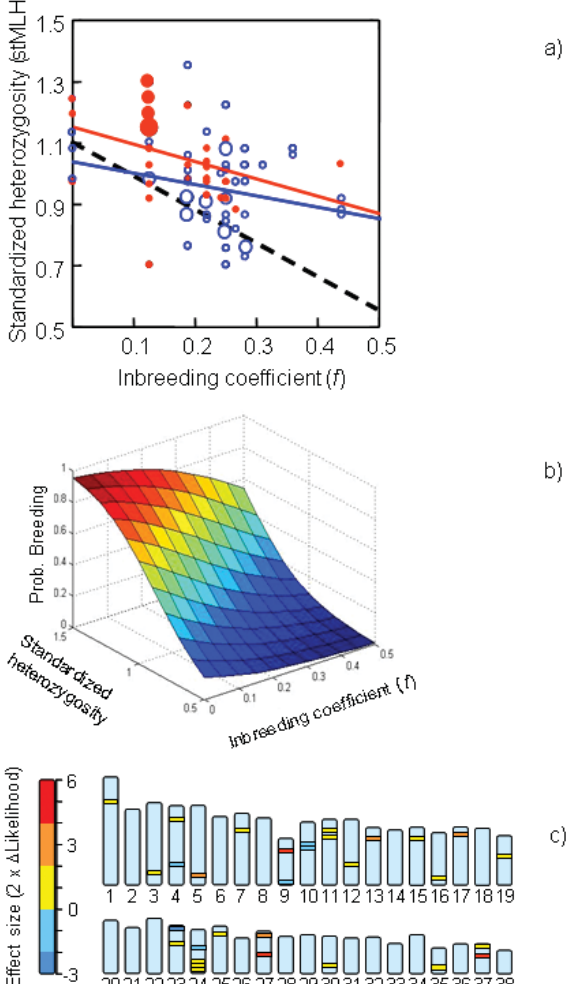
Figure 2. Reproductive status and inbreeding coefficients of Scandinavian wolves in relation to heterozygosity and chromosomal location of 31 microsatellite loci. a) The relationship between inbreeding coefficient ( f ) and standardized heterozygosity (stMLH). Individuals that recruited to the breeding population (filled red circles, solid red regression line) exhibited higher stMLH than those that did not enter the breeding population (open blue circles, solid blue regression line) (ANCOVA: inbreeding coefficient, F 1,82 =7.96, P =0.006; breeding recruitment success , F 1,82 =7.43, p =0.008). The stippled black line shows the expected relationship between f and stMLH. b) Breeding probability against inbreeding coefficient ( f ) and stMLH based on model estimates from a logistic regression analysis ( f , b = 2 5.84, p =0.06; stMLH, b =4.87, p =0.017). Relative to the population mean values of f (0.207) and stMLH (1.0), an increase of 1 SD in f corresponds to a 32% reduction in breeding probability, and a decrease of 1 SD in stMLH corresponds to a 40% reduction in breeding probability c) The effects of heterozygosity on the recruitment success of wolves for each of the 31 microsatellite markers and their locations on the autosomal chromo- somes in the dog genome. The statistical effect is measured as two- times the likelihood difference between the model with the marker and the null model; positive values (yellow-red) indicate positive associa- tions, negative values (blue) negative associations.